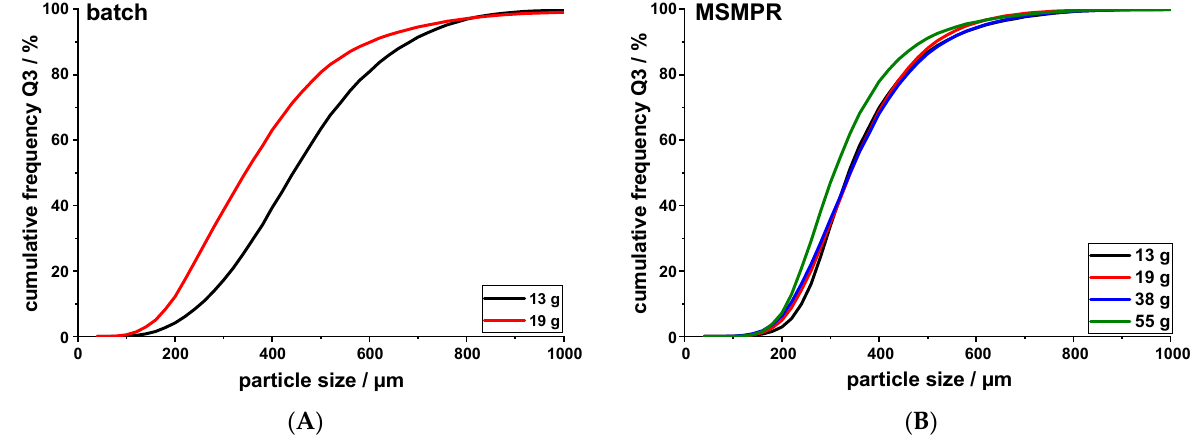
Figure 11. ( A ). Change in PSD of QESD MF agglomerates by increasing batch size using a batch crystallizer vs. ( B ). a MSMPR crystallizer ( n = 1, entire batch).